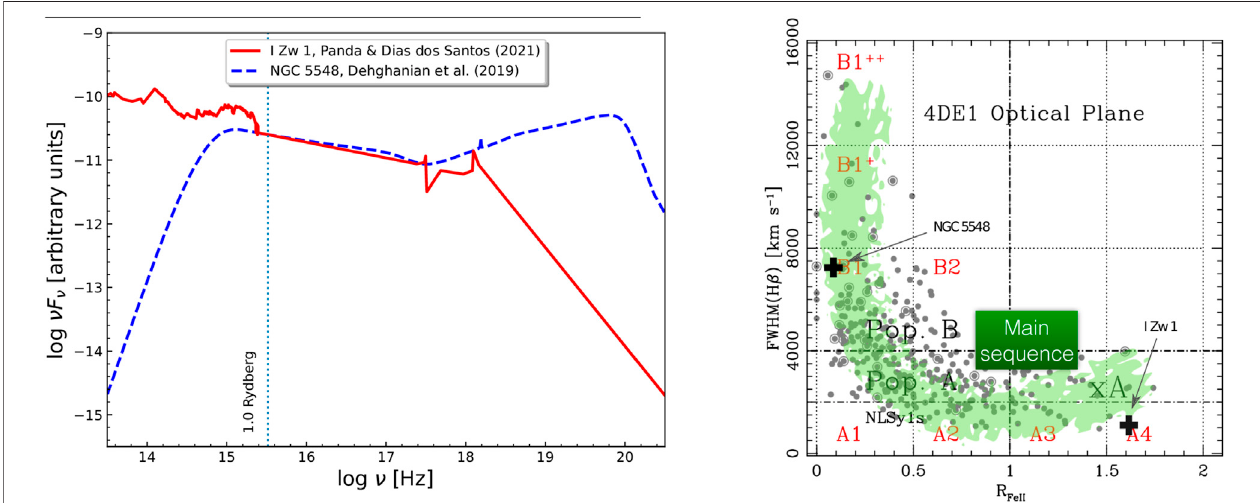
FIGURE1| (Left)Comparisonofthespectralenergydistributions(SEDs)forIZw1(inred)andNGC5548(indashedblue).TheIZw1SEDistakenfromPandaand DiasdosSantos(2021),andforNGC5548weusetheDehghanianetal.(2019)versionoftheMehdipouretal.(2015)SED.TheSEDsarenormalizedat1Rydberg(right) optical plane of the quasar main sequence (or 4DE1). Abridged version of Marziani et al. (2018). The locations of I Zw 1 (Marziani et al., 2021, submitted) and NGC 5548 Du and Wang (2019) are marked with plus